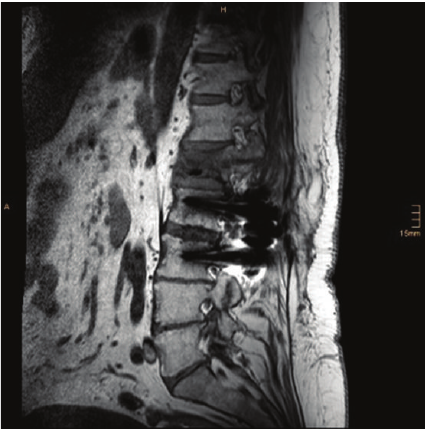
Figure 4: Postoperative sagittal MRI (T1-weighted) at the level of the pedicles (left).